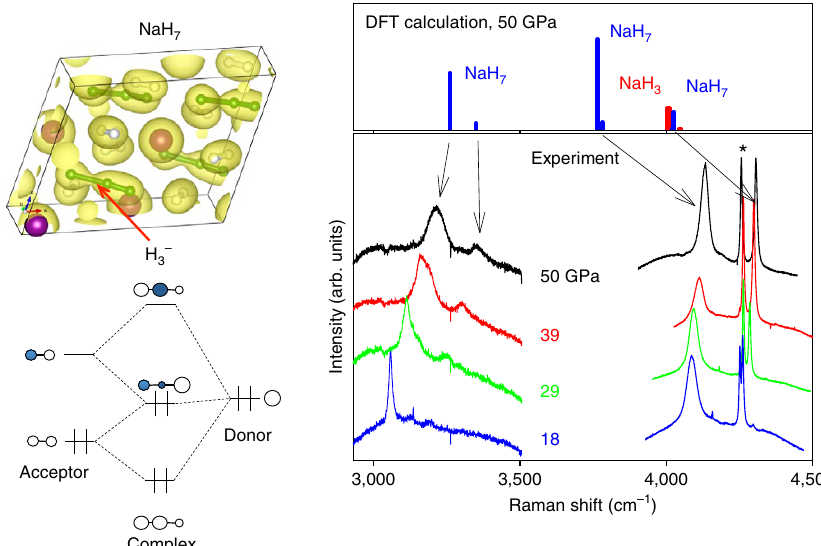
Figure 2 | H 3 (cid:2) complexes in NaH 7 and Raman spectra of NaH 3 and NaH 7 . The right panel shows higher-frequency vibrons from H 2 molecular-type structural units. The left panel shows the structure of NaH 7 , which contains H 3 (cid:2) complexes. The isosurface is plotted at the level of 0.07 electrons n Å (cid:2) 3 . One of H 2 molecules is bonded to a hydrogen atom in the NaH unit with a bond length of z ¼ 1.25Å, and they form a H 3 (cid:2) linear anion in NaH x materials with x ¼ 7. A detailed charge analysis is presented below (Fig. 6). The schematic diagram for H 3 (cid:2) molecular orbitals (adopted from ref. 48 for I 3 (cid:2) ) is also shown. Donor stands for the hydride ion H (cid:2) , and acceptor for the H 2 unit attached to H (cid:2) . Right panel: Raman spectra of the NaH 7 sample are shown in the frequency range (3,000–3,500cm (cid:2) 1 ) typical for vibrons from H 3 (cid:2) units (indicated in the structure of NaH 7 as green-yellow dumbells). The Raman response in 4,000–4,300cm (cid:2) 1 region is a mixture of H 2 vibron modes of NaH 3 and NaH 7 . The top panel shows the calculated Raman frequencies and intensities for NaH 3 and NaH 7 . The Raman signal from a pure H 2 vibron is indicated by an